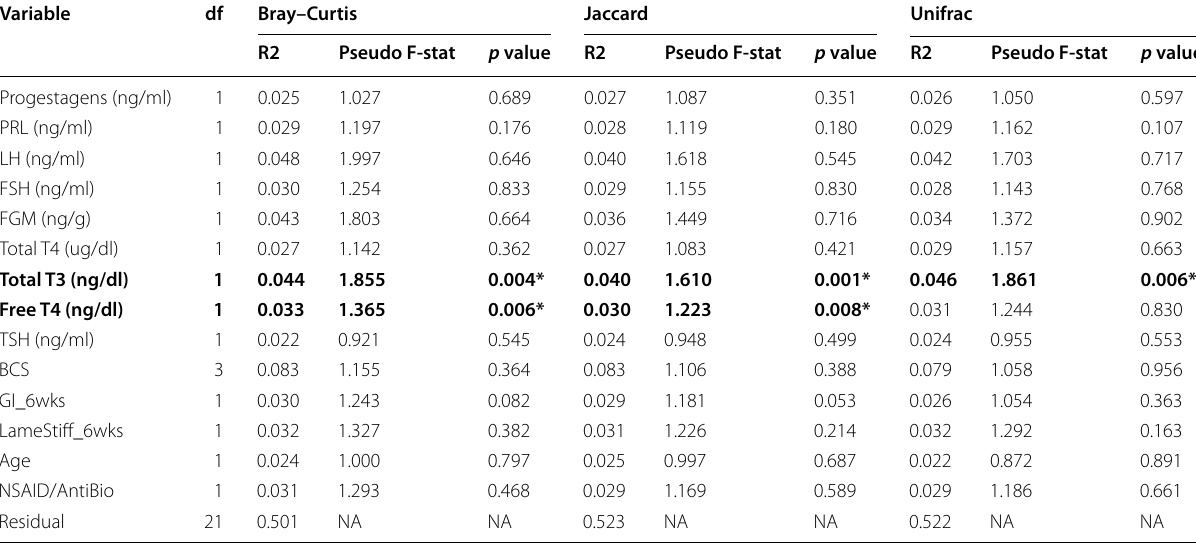
Bold text indicates variables with significant p values